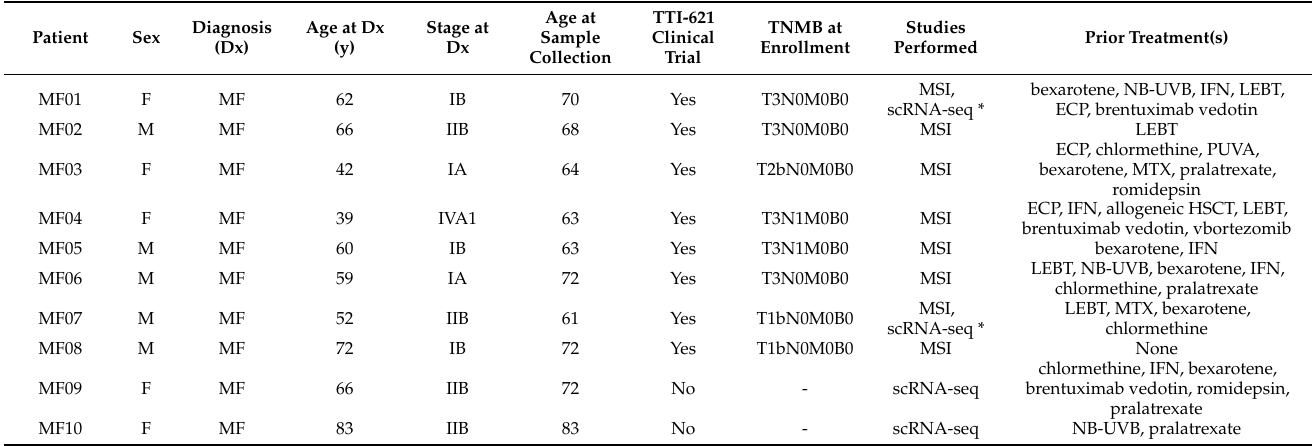
Table 1. Patient